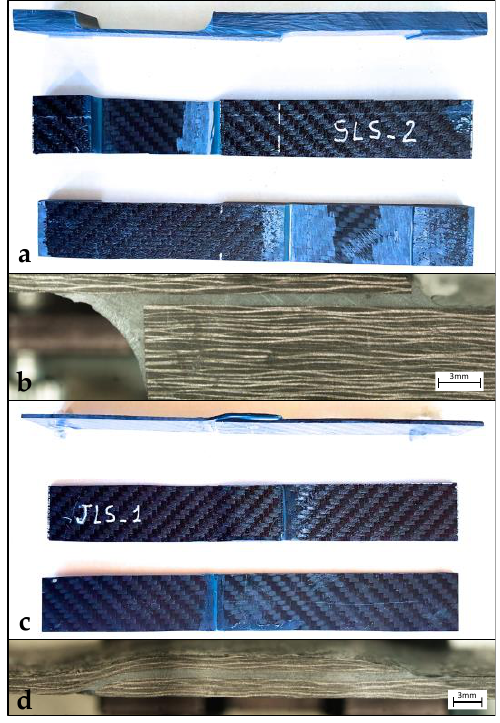
Figure 2. ( a ) SLS specimen, ( b ) joint overlap of SLS specimen, ( c ) JLS specimen, ( d ) joint overlap of Figure 2. (a) SLS specimen, (b) joint overlap of SLS specimen, (c) JLS specimen, (d) joint overlap of JLS JLS specimen.